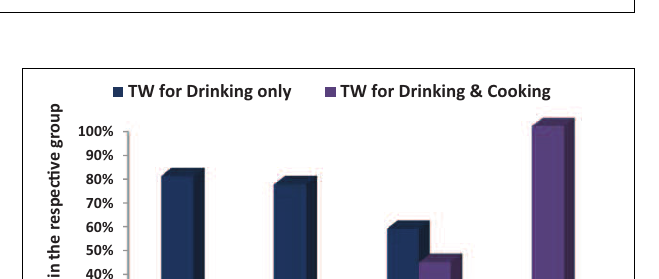
FIGURE 10 | Influence of education on user’s preference for use of Tubewell water.